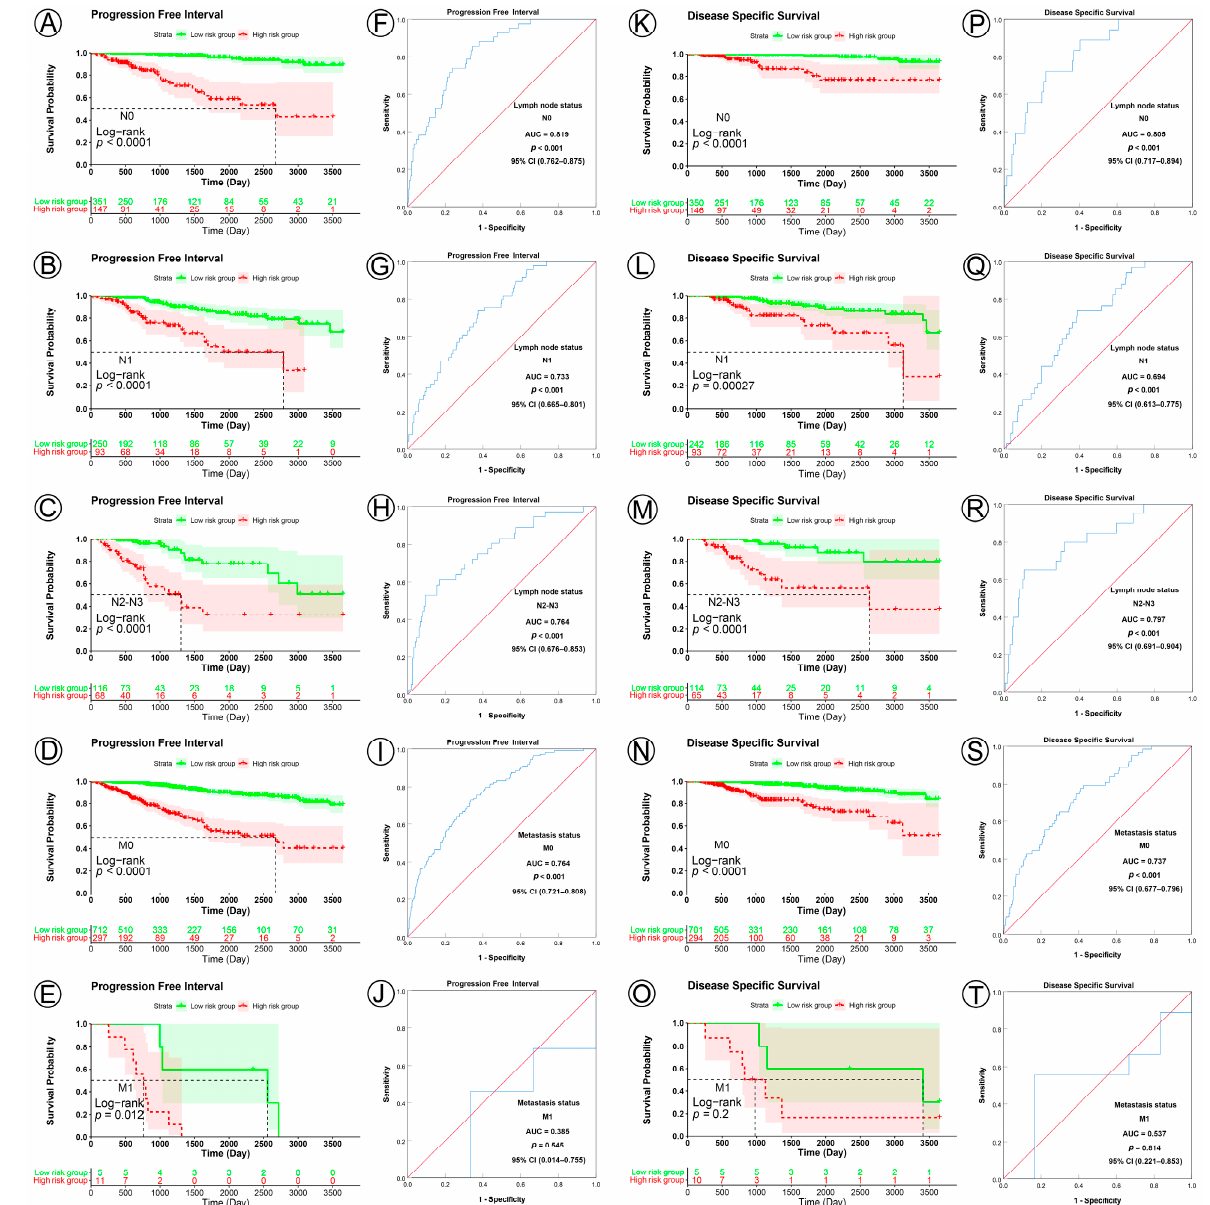
Figure 6. KM and ROC curve analyses of patients stratified by lymph node and metastasis status. ( A – E , K – O ) KM curves of PFI and DSS for high- and low-risk groups in the N0, N1, N2–N3, M0, and M1 subgroups. ( F – J , P – T ) ROC analysis showed the sensitivity and specificity of the prognostic signature for predicting PFI and DSS for high- and low-risk groups in the N0, N1, N2–N3, M0, and M1 subgroups.